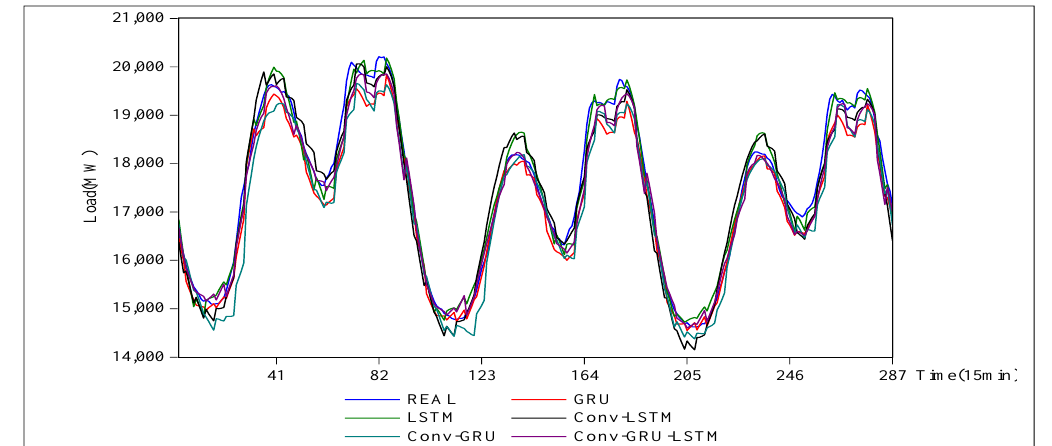
Figure 8. Comparison of prediction results.